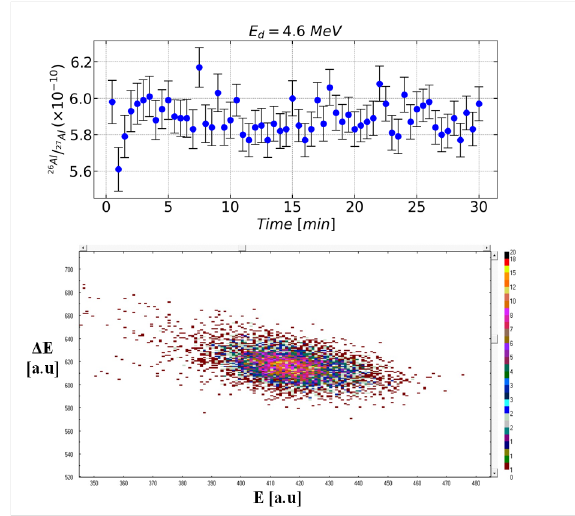
Figure 4. Some results achieved for the counting of 26 Al us- ing AMS. On top the 26 Al / 27 Al ratio for 4.6 MeV. The ∆ E-E spectrum on bottom figure shows exclusive 26 Al events produced from one of the targets irradiated with deuterium.